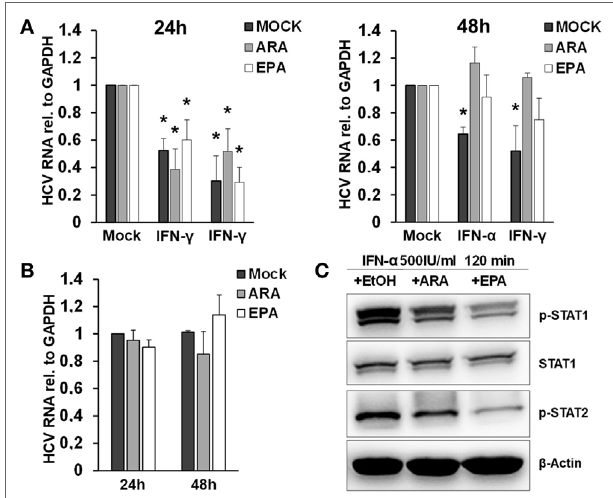
FigUre 6 | Polyunsaturated fatty acids modulate extracellular vesicle (EV)-mediated innate antiviral immunity. (a) THP-1 macrophages were treated pretreated with mock (black bar), arachidonic acid (ARA) (gray bar), and eicosapentaenoic acid (EPA) (white bar) for 24 h (left) and 48 h (right), respectively. Then, EVs were isolated from conditioned supernatants 24 h after pulsation with mock, IFN- α (500 IU/ml), or IFN- γ (25 ng/ml) for 1 h, respectively. Purified EVs containing 100 µg of protein were transferred to Huh-7.5 hepatoma cells harboring subgenomic hepatitis C virus (HCV) replicons. HCV mRNA levels were quantified by Taqman real-time PCR (RT-PCR) after 96 h. Mean and SEM of three biological replicates are shown. (B) Huh-7.5 hepatoma cells harboring subgenomic HCV replicons were exposed to mock (black bar), ARA (5 µg/ml, gray bar), or EPA (5 µg/ml, white bar) for 24 and 48 h, and HCV mRNA levels were quantified by Taqman RT-PCR. Mean and SEM of three biological replicates are shown. (c) Western blot analysis of p-STAT1 and p-STAT2 in cell lysates of THP-1 cells were treated with mock (EtOH), ARA (5 µg/ml), or EPA (5 µg/ml) for 48 h before stimulation with IFN- α (500 IU/ml) for 120 min (* P <